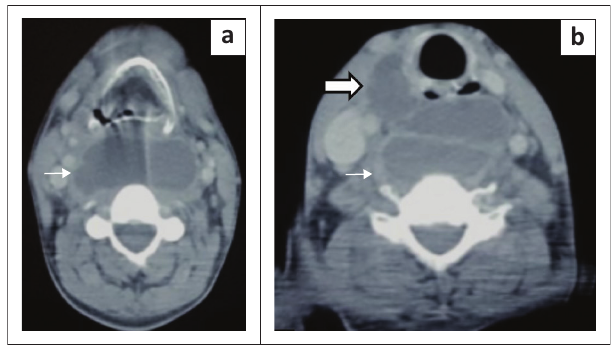
FIGURE 2: Axial contrast-enhanced CT scan of the neck, at the level of the hyoid bone (a) and at the level of sixth cervical vertebra (b), reveals a peripherally enhancing cystic lesion (thin arrows in a and b) involving the retropharyngeal and prevertebral space with extension to the anterior cervical and visceral space (thick arrow in b).